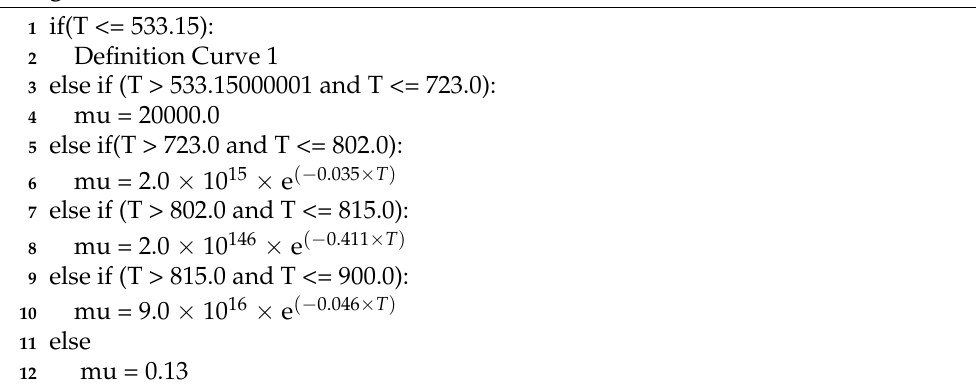
Algorithm A3: Definition of the curve